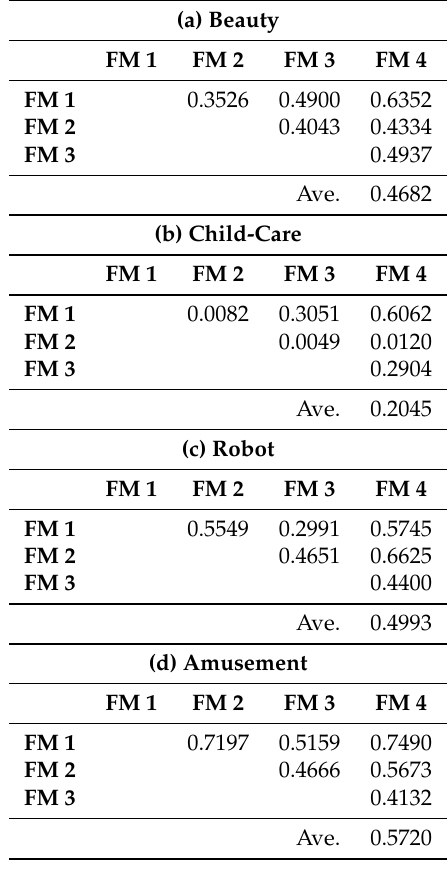
Table 2. Weighted Cohen’s κ for four-category task among four experienced fund